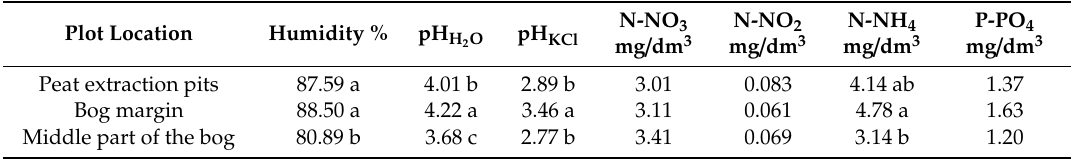
Table 6. Characteristics of peat soil habitats depending on their location on the bog. Former peat extraction pits (S1-2, ZB1-3, N1 and N3), bog margin (T1, SD1-2 and Z1), middle part of the bog (R1-3 Table 4. Characteristics of birch bog habitats varied in terms of humidity. and